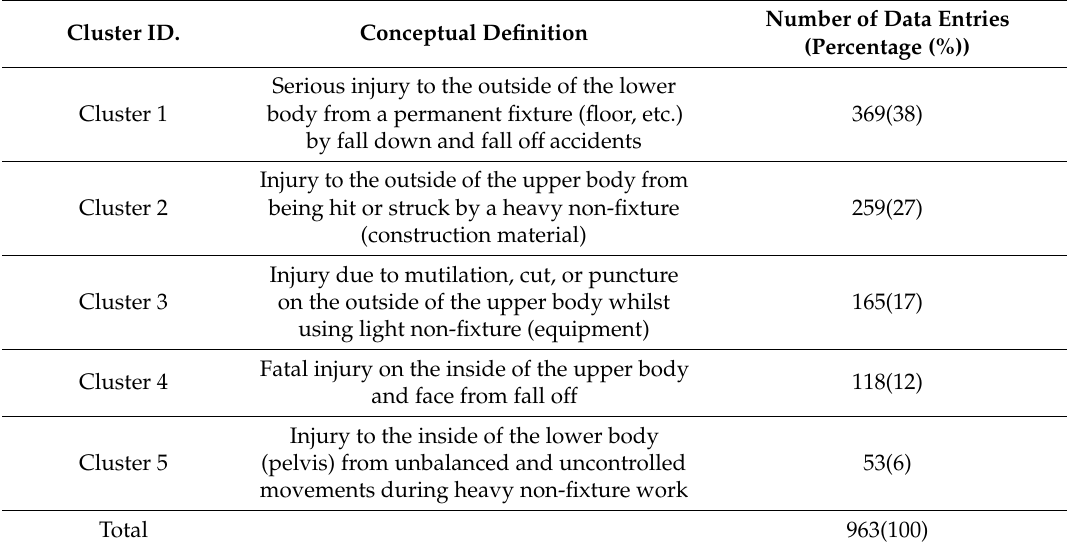
Table 7. Concept definitions of construction accidents by